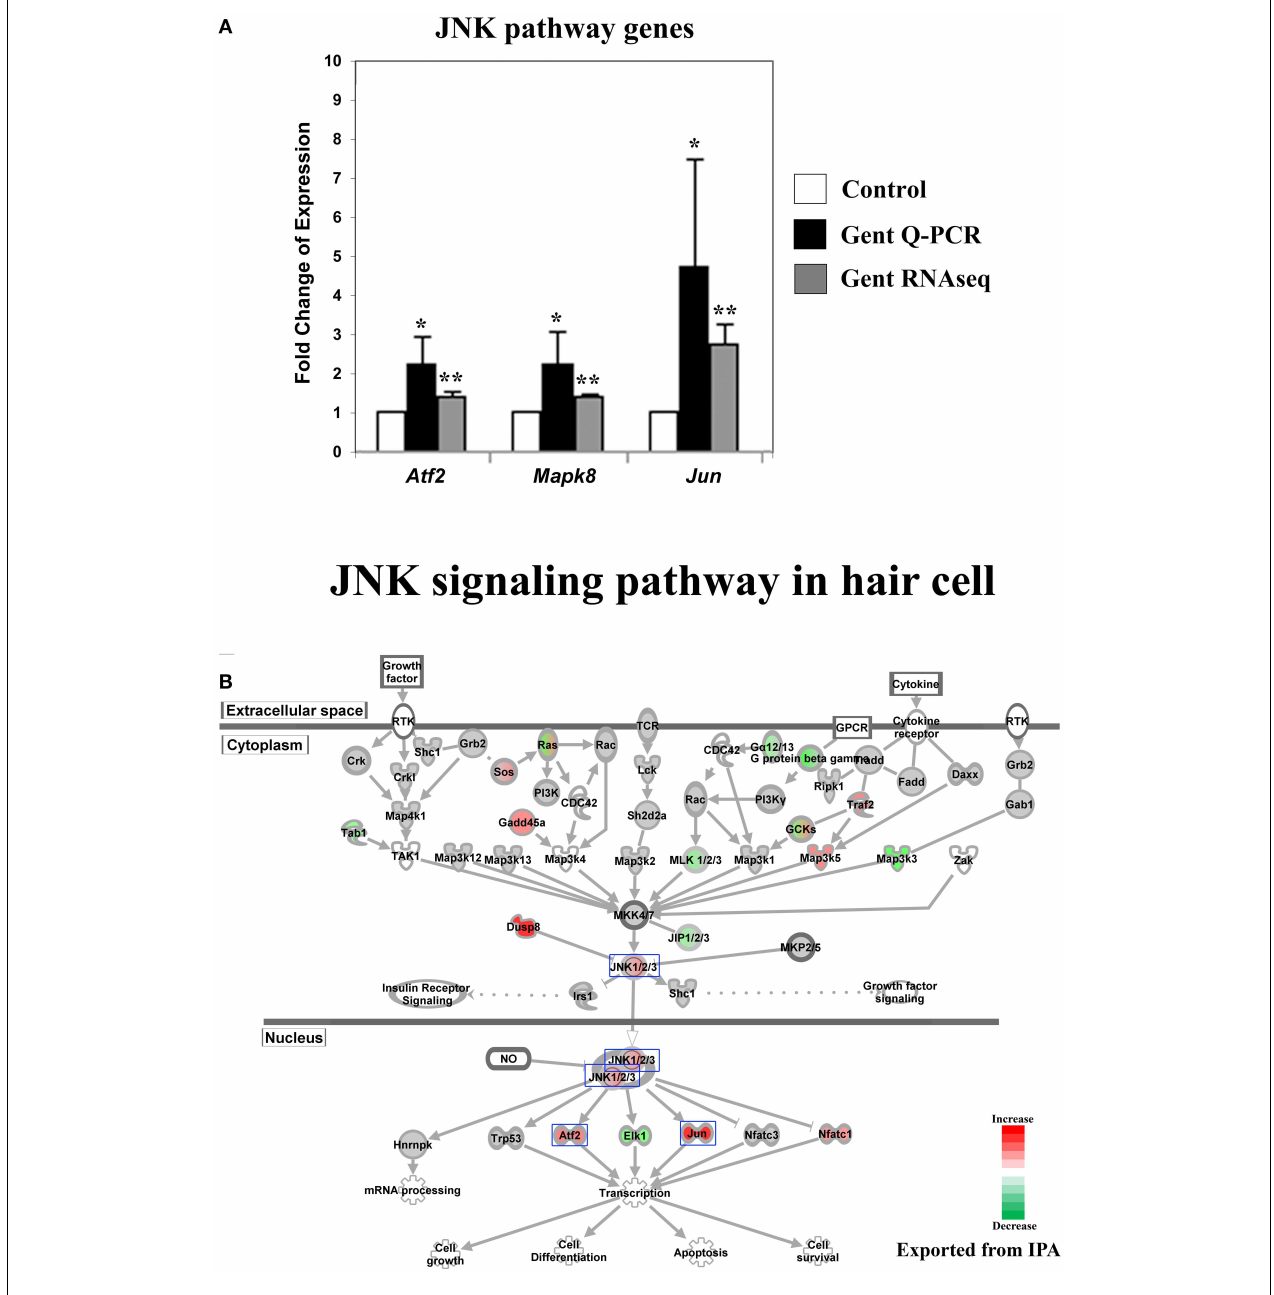
FIGURE 2 | Gentamicin-induced changes in expression of genes in the Jun-kinase (JNK) pathway. (A) Q-PCR results validating increased messenger RNA levels in hair cells after gentamicin treatment. Error bar, standard deviation: * p < 0 . 05 ; ** p < 0 . 01 . (B) The JNK signaling pathway with color-codedexpressionchangesindicatingsignificanttranscriptionalresponse